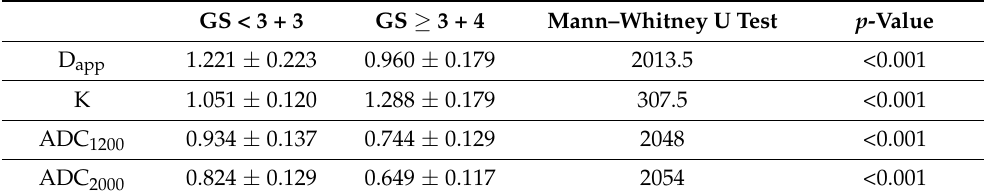
Figure 4. Box-and-whisker plots of mean values for DKI parameters and standard ADC according to Gleason score (GS ≤ 3 + 3 in blue, GS ≥ 3 + 4 in orange) ( p < 0.001). *** stands for p < 0.001. Mean D app , ADC 1200 , and ADC 2000 were significantly lower ( p < 0.001) in GS ≥ 3 + 4 compared to GS 3 + 3 tumors (0.960 ± 0.179 vs. 1.221 ± 0.223 × 10 −3 s/mm 2 , 0.744 ± 0.129 vs. 0.934 ± 0.137 s/mm 2 and 0.649 ± 0.117 vs. 0.824 ± 0.129 s/mm 2 , respectively). Mean K values were significantly higher in GS ≥ 3 + 4 compared to GS 3 + 3 tumors: 1.288 ± 0.179 vs. 1.051 ± 0.120 ( p < 0.001) as shown in Table 3. Table 3. Mean values of DKI diffusion parameters and ADC in prostate cancer lesions according to Gleason score.